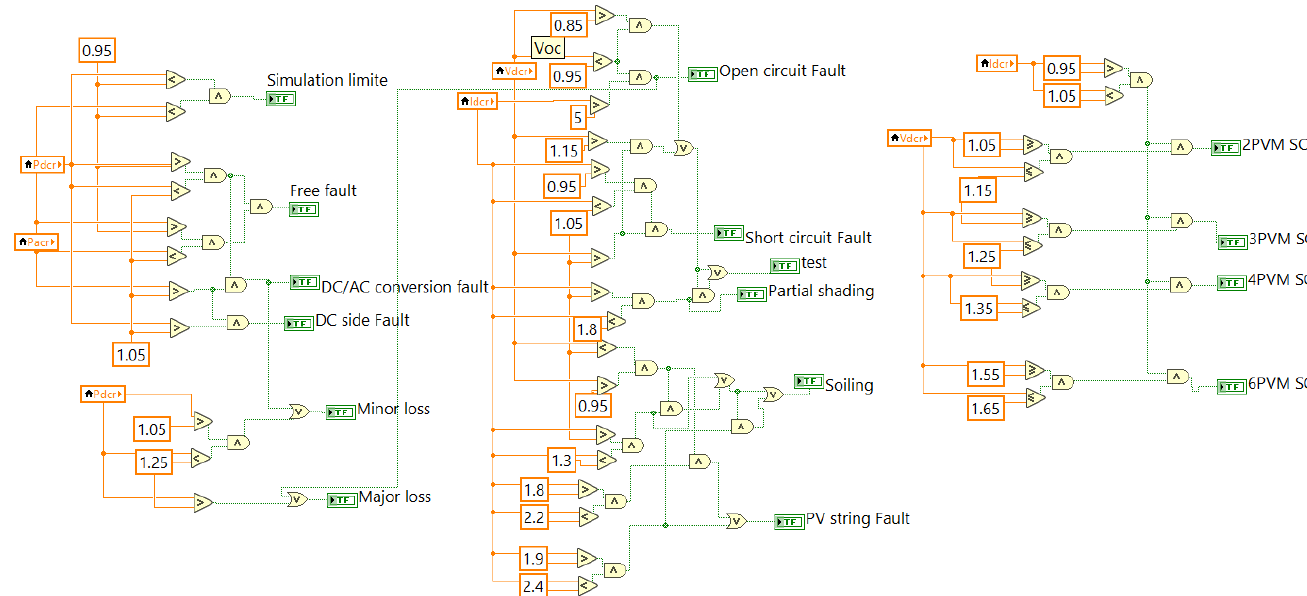
Figure 19. Flowchart of the developed strategy to detect and identify the DC and AC anomalies affecting the GCPVS.